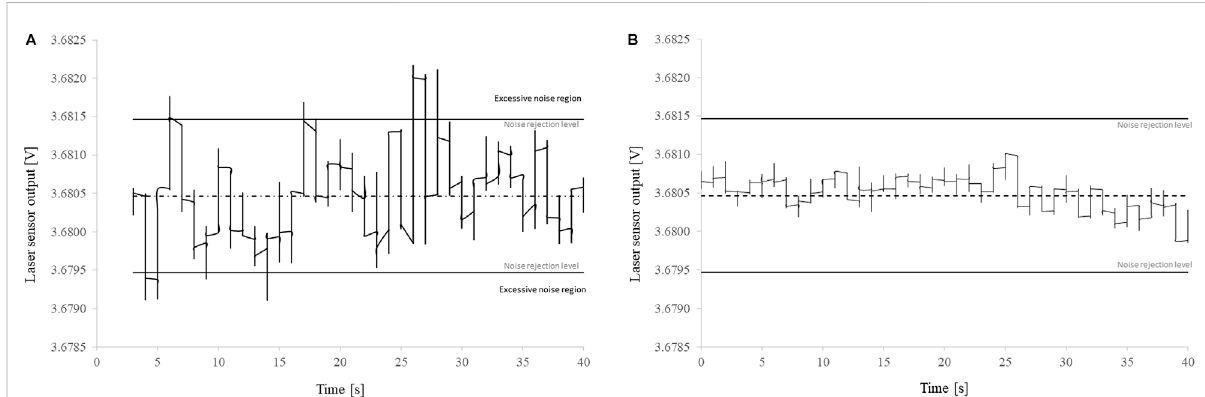
FIGURE 7 Laser sensor output. Both signals were averaged with a running average of sub-set size 800. The signal average is represented by a dashed line and the sensor ’ s resolution limit by a continuous line. (A) Without other electrical equipment ’ s working in the proximity, the noise level is effectively averaged below the sensor ’ s resolution. (B) With other equipment ’ s working in the proximity the existence of power surges and harmonics in the electrical power network affects the DC output of the laser sensors making the distance measurement oscillate with